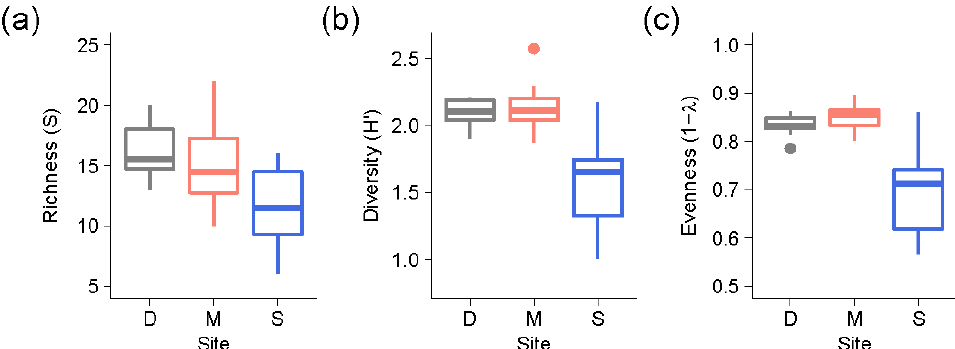
Figure 2. Boxplots of ( a ) richness (S), ( b ) diversity (H’) and ( c ) evenness (1 − λ ) of lichen taxonomic group versus site (D = Danum Valley Conservation Area, M = Maliau Conservation Area [old growth sites]; S = Stability of Altered Forest Ecosystems [SAFE] Project area [logged